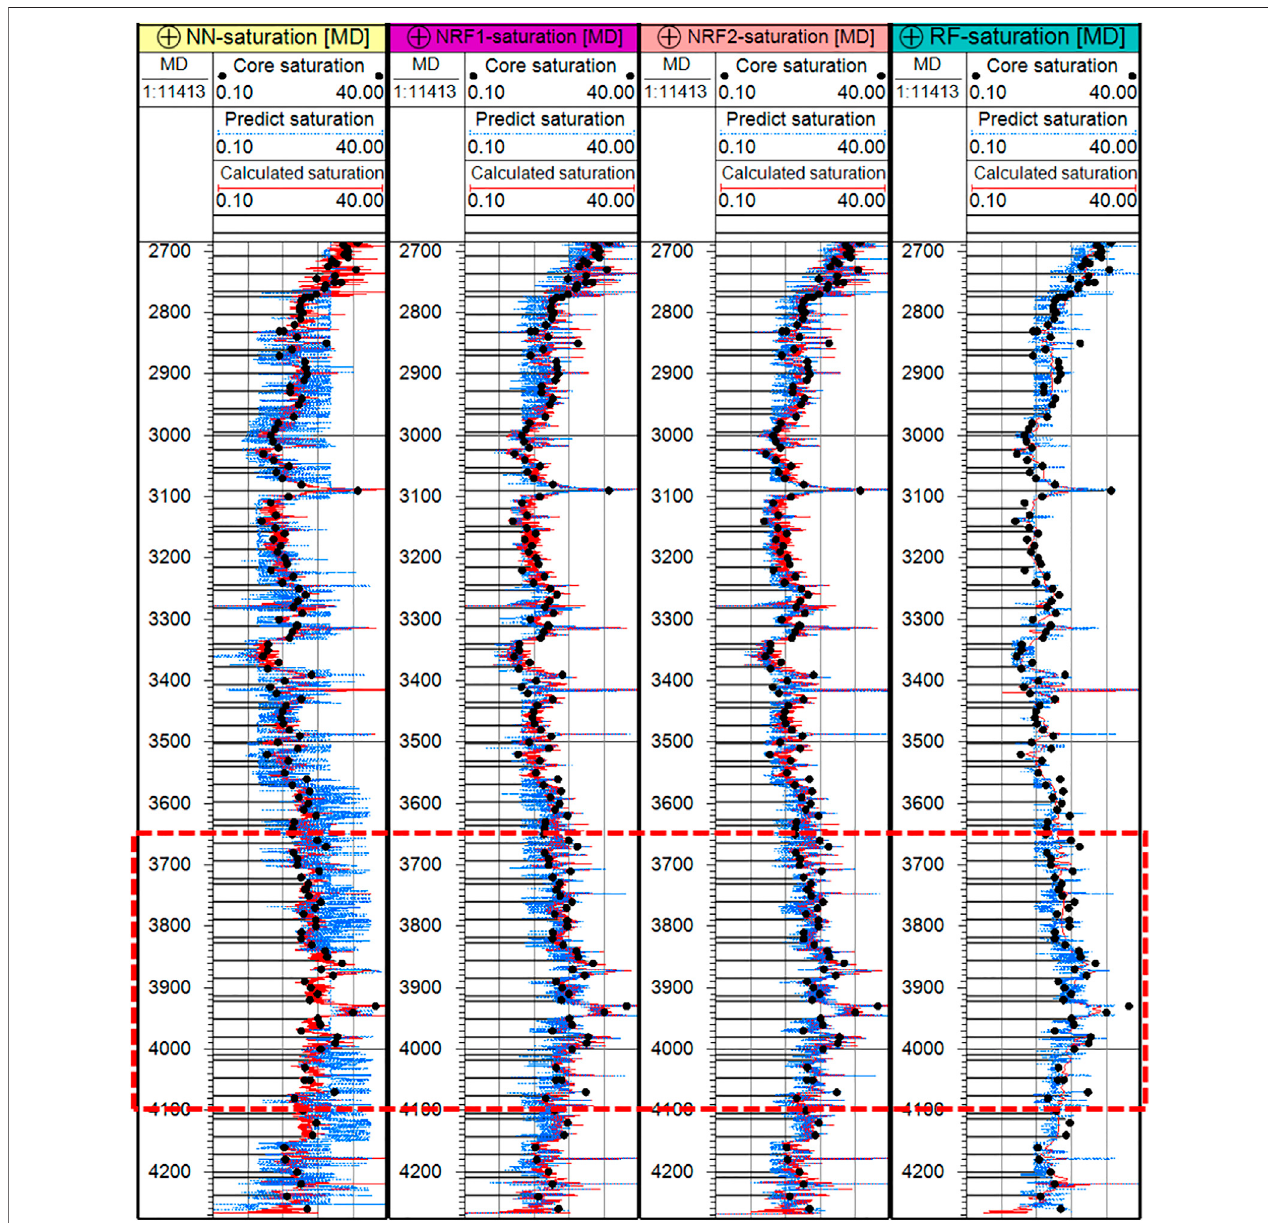
FIGURE 7 | Comparison between actual and predicted saturation data in different models